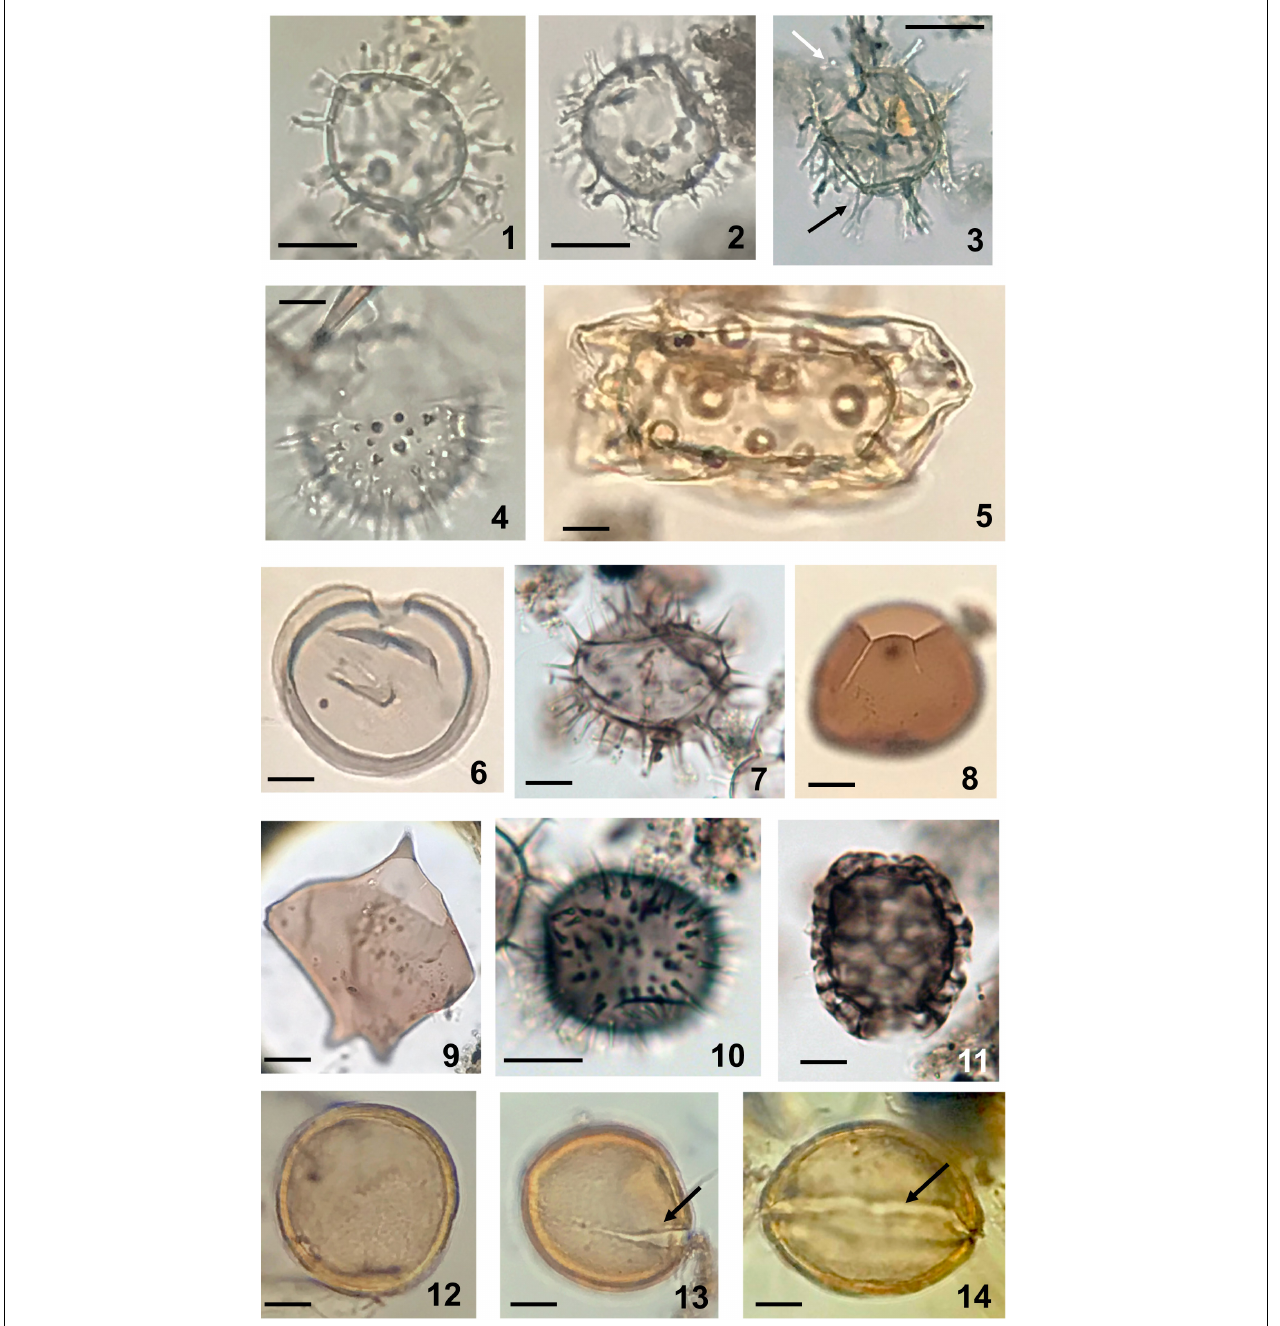
FIGURE 4 | Dinoflagellate cysts (1-11) and acritarch (112-14) observed in sediments of Beppu Bay. (1) Spiniferites bulloideus (Deflandre and Cookson) Sarjeant; photosynthetic. Sample BG19 St 1 2 10-11. (2) Spiniferites delicatus Reid; photosynthetic. Sample BG19 St 1-2 10-11. (3) Hiddenocysta matsuokae P. Gurdebeke, V. Pospelova, K.N. Mertens , and S. Louwye ; probably photosynthetic, black arrow indicating fenestrate process, white arrow indicating larger precingular archeopyle. In statistical analysis this species is included in Spiniferites spp. Sample BG19 St 1-2 14-15. (4) Lingulodinium machaerophorum (Deflandre and Cookson) Wall; photosynthetic. Sample BG19 St 1-2 14-15. (5) Tuberculodinium vancampoae Rossignol; photosynthetic. Sample BG19 St 1-2 28-29. (6) Selenopemphix nephroides Benedeck; heterotrophic. Sample BG19 St 1-2 10-11. (7) Selenopemphix quanta (M.R. Bradford) Matsuoka; heterotrophic. Sample BG19 St 1-2 14-15. (8) Votadinium calvum Reid; heterotrophic. Sample BG19 St 1-2 64-65. (9) Cyst of Protoperidinium latissimum* (Kofoid) Balech; heterotrophic. Sample BP09-6 3-22. (10) Cyst of Niea acanthocysta* (H. Kawami, M. Iwataki , and K. Matsuoka ) T. Liu, K.N. Mertens, and H. Gu; heterotrophic. Sample BG19